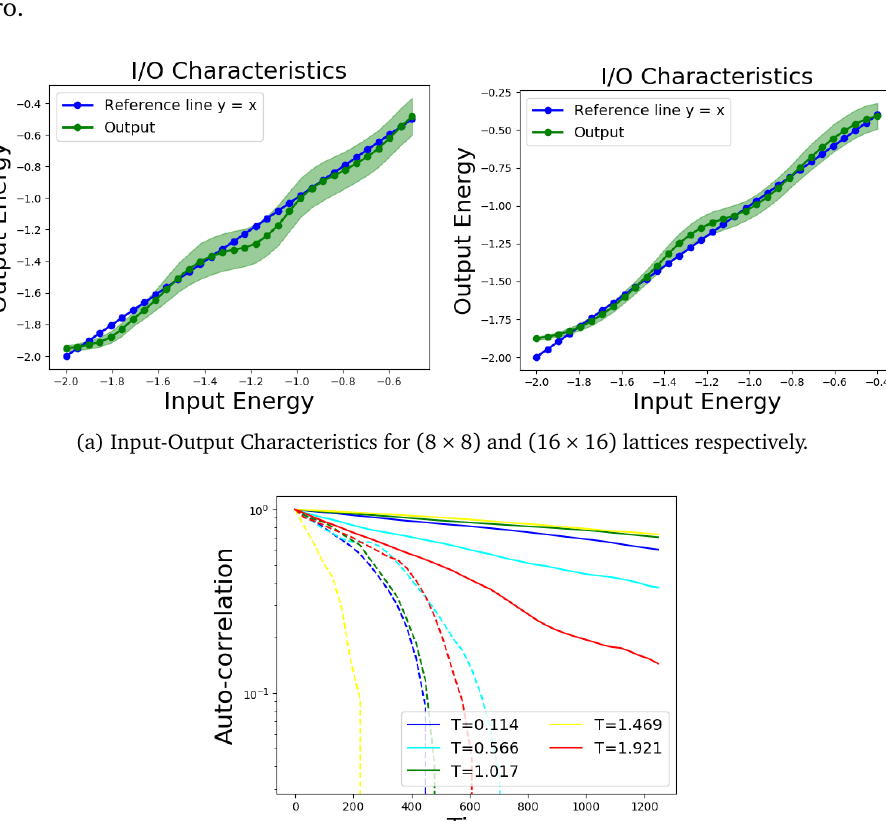
Figure 6: Average value of Y-component of magnetization computed over 500 con- figurations. Due to pre-processing of the MCMC data, the curves should be close zero.